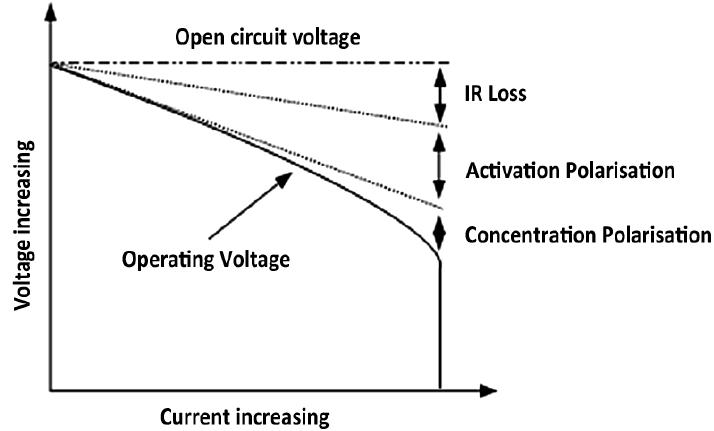
Figure 14. Cell polarization in function of current rate [71].